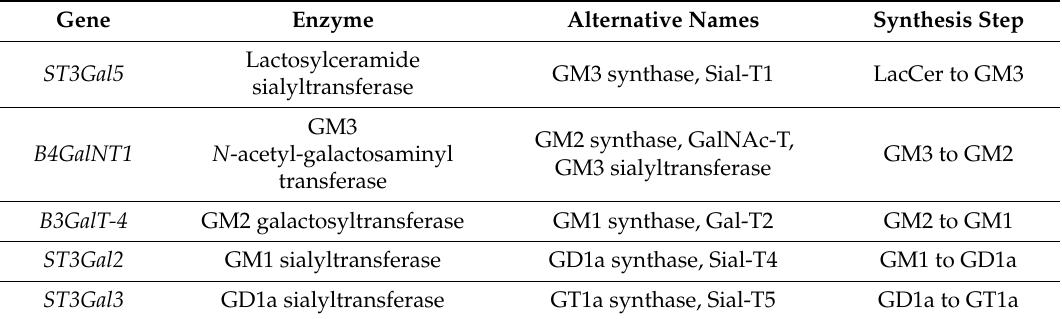
Table 1. Genes and enzymes involved in a-series ganglioside biosynthesis. Only steps beyond LacCer are